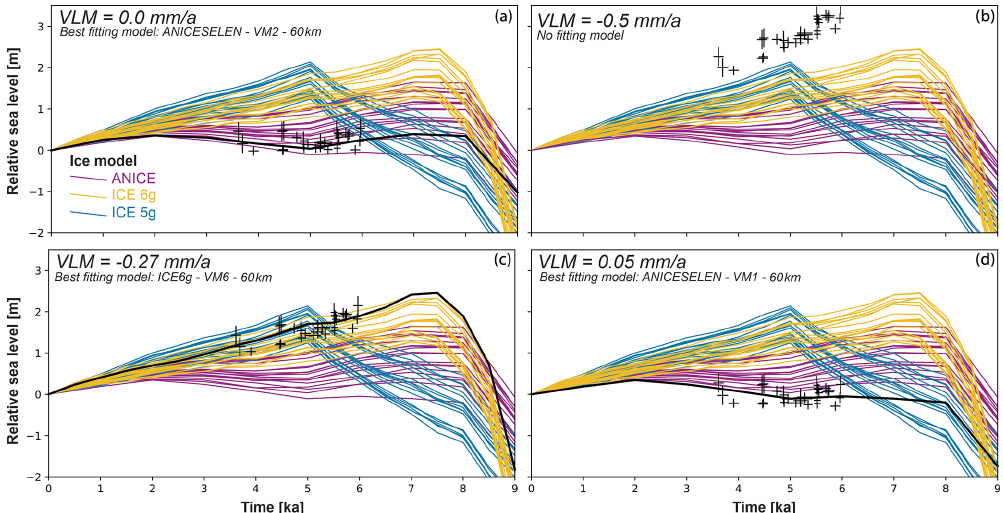
Figure 11. Comparison between RSL observations (except the island of Barrang Lompo) and predictions from GIA models (see Table 1 for model details). The model predictions were extracted by averaging latitude and longitude of all islands reported in this study, minus Barrang Lompo. Colored lines represent ANICE, ICE5g, and ICE6g models. Thicker, black lines identify the best fitting models. The different panels (a–d) show different tectonic corrections applied to the observed RSL data. The Jupyter notebook used to create this graph is available in Rovere et al.